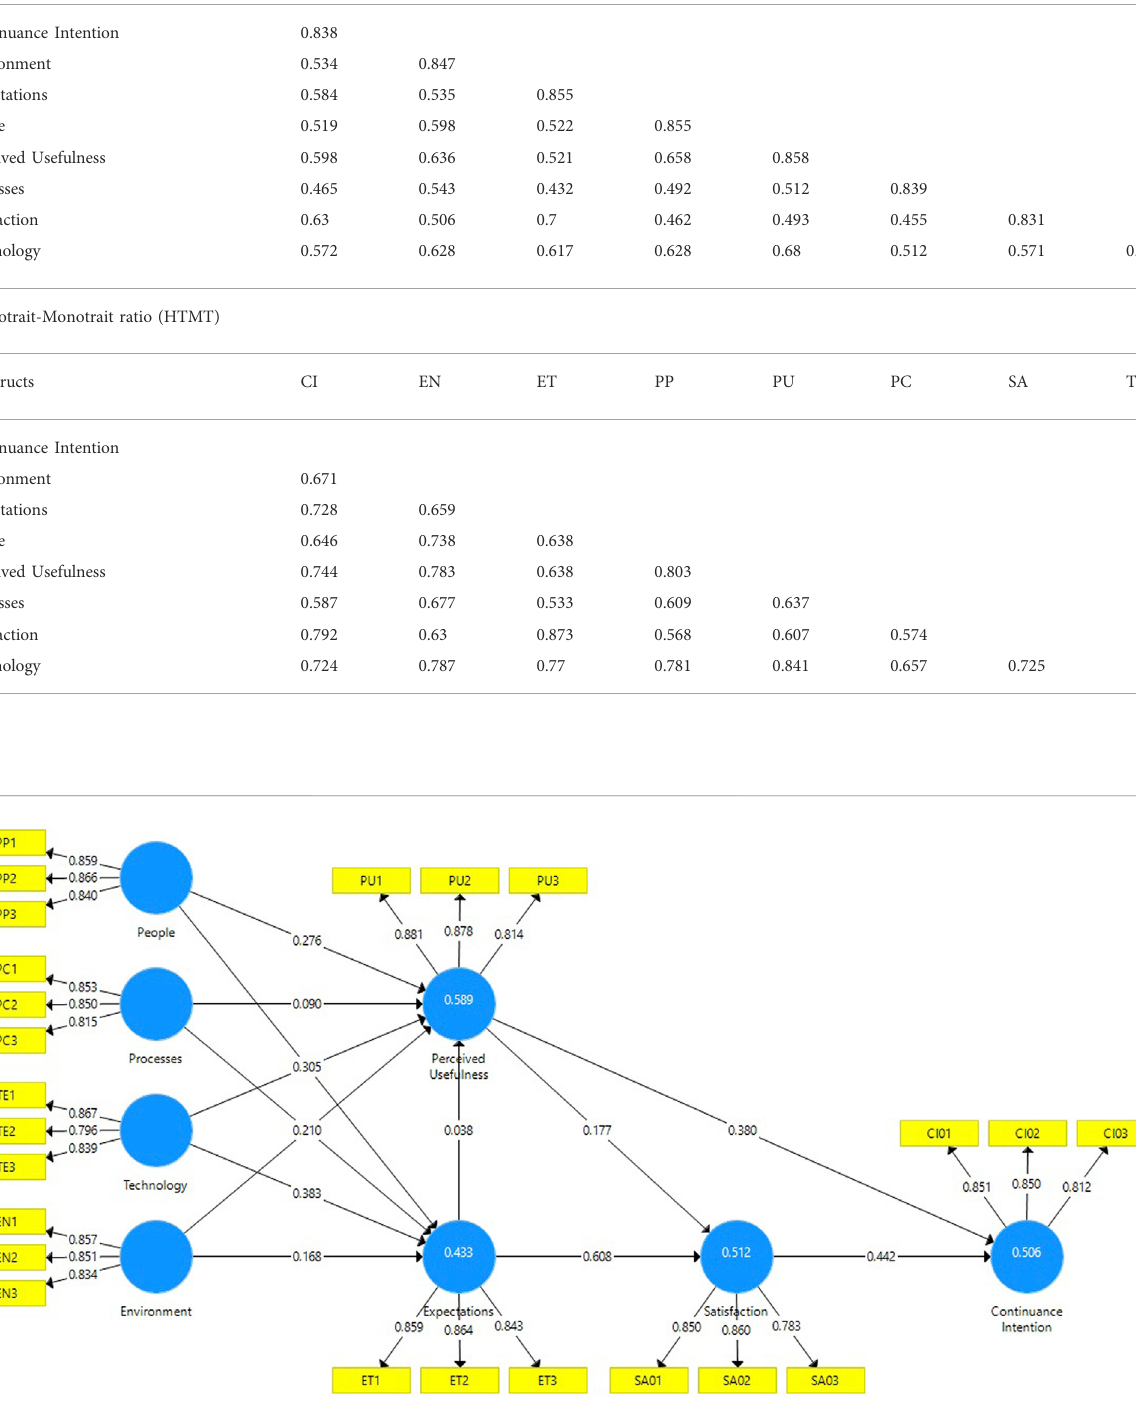
FIGURE 4 PLS algorithm